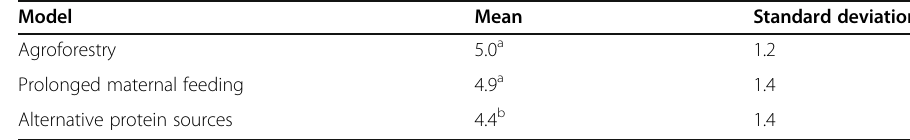
Table 12 Descriptive statistics for intention to purchase ratings (all countries) Model Agroforestry Prolonged maternal